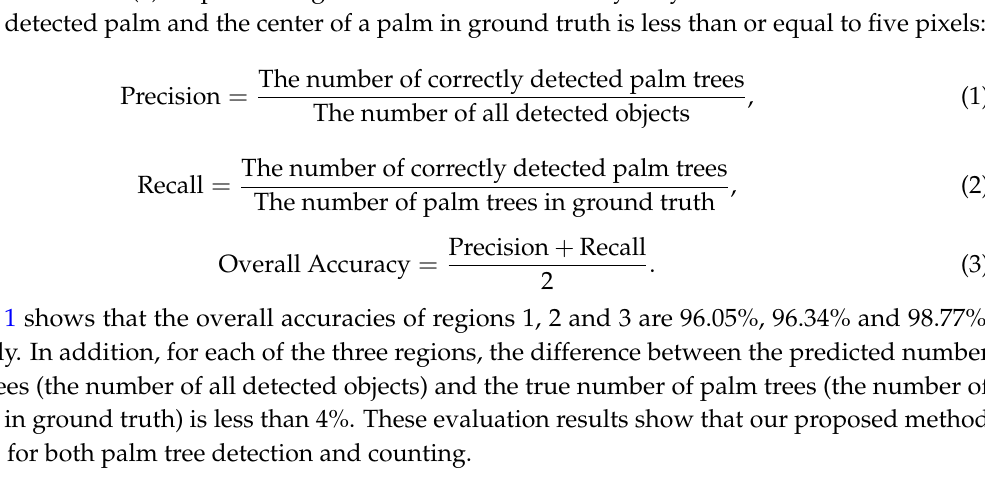
Table 1. Detection results of convolutional neural network